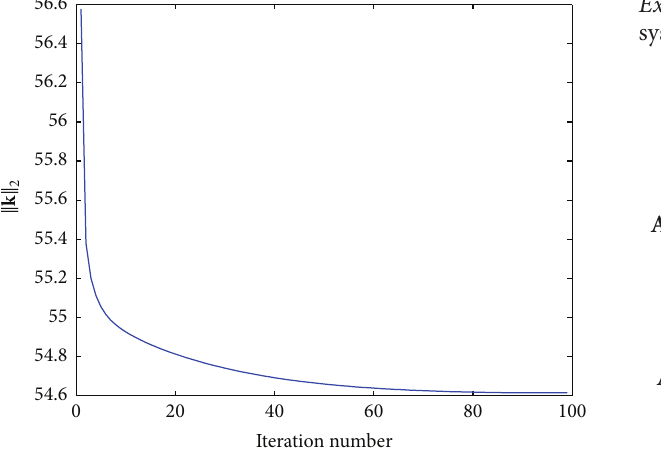
Figure 1: Iterative process of Example 1.